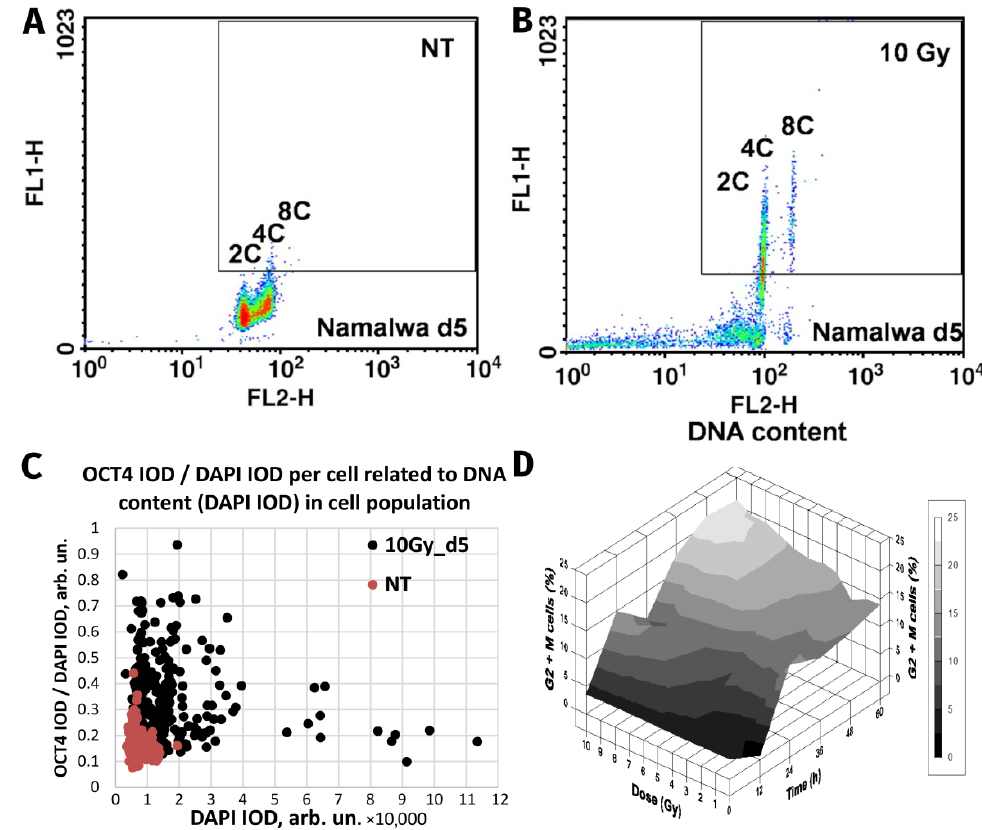
Figure 1. The similarity of responses to acute Irradiation (10 Gy) of the malignant human Burkitt’s lymphoma cell line Namalwa and benign rat liver progenitor stem line WB-F344. Radiation-induced Oct4 upregulation in Namalwa cells as revealed by flow cytometry: panel ( A ) unirradiated cells (control); panel ( B ) irradiated cells on day 5 post-irradiation. According to the extent of the FL1-signal (immunofluorescence from Oct4), Oct4 is predominantly expressed in polyploid 4C and 8C cells whose DNA content was determined by propidium iodide staining for DNA (FL2-signal) (reprinted with permission from [34]. Copyright ID 1188250-1, 2022, Elsevier Science &Technology Journals). Panel ( C ) radiation-induced Oct4 upregulation in WB-F344 cells as revealed by two-parametric image analysis of integral optical densities (IOD): represented as Oct4 (IOD)/DAPI (IOD) versus DAPI (IOD). Panel ( D ) radiation-induced G2/M delay in WB-F344 cells which is dose- and time-dependent (image from [78]).